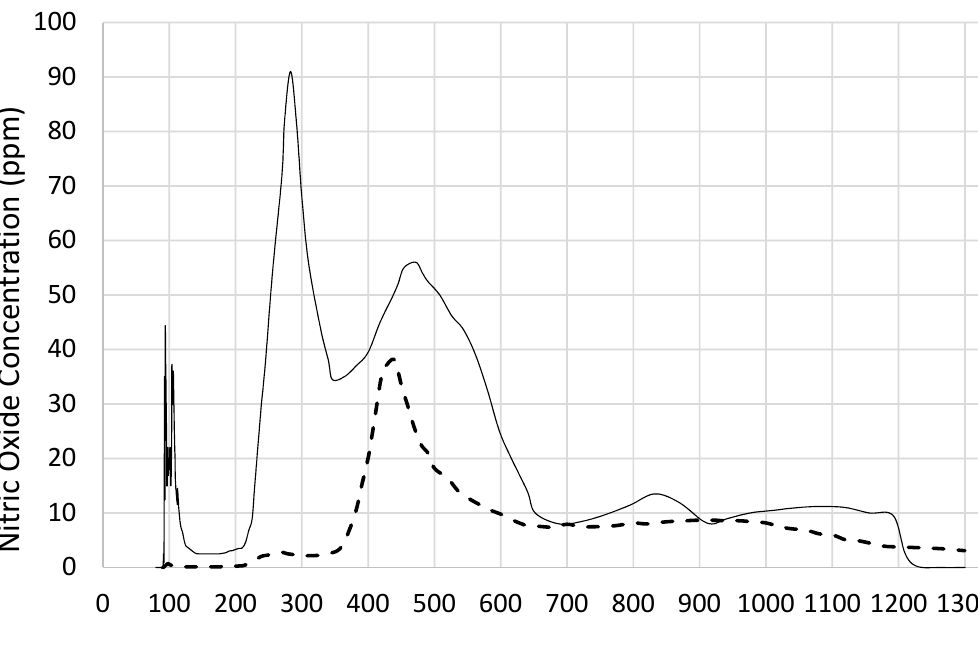
Figure 3. Temperature programmed pyrolysis of cobalt nitrate when: - - - [Si] = 0 and – [Si]/[Co] = 4. Variation of nitric oxide concentration (ppm) with temperature.